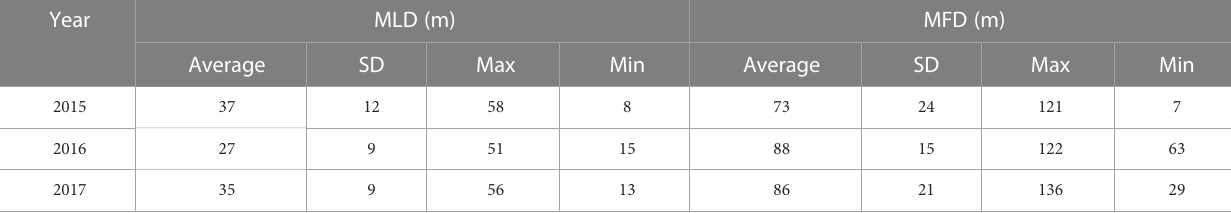
TABLE 2 Mixed layer depth and maximum fl uorescence depth during three cruises covering the southern Gulf of Mexico ’ s deep-water